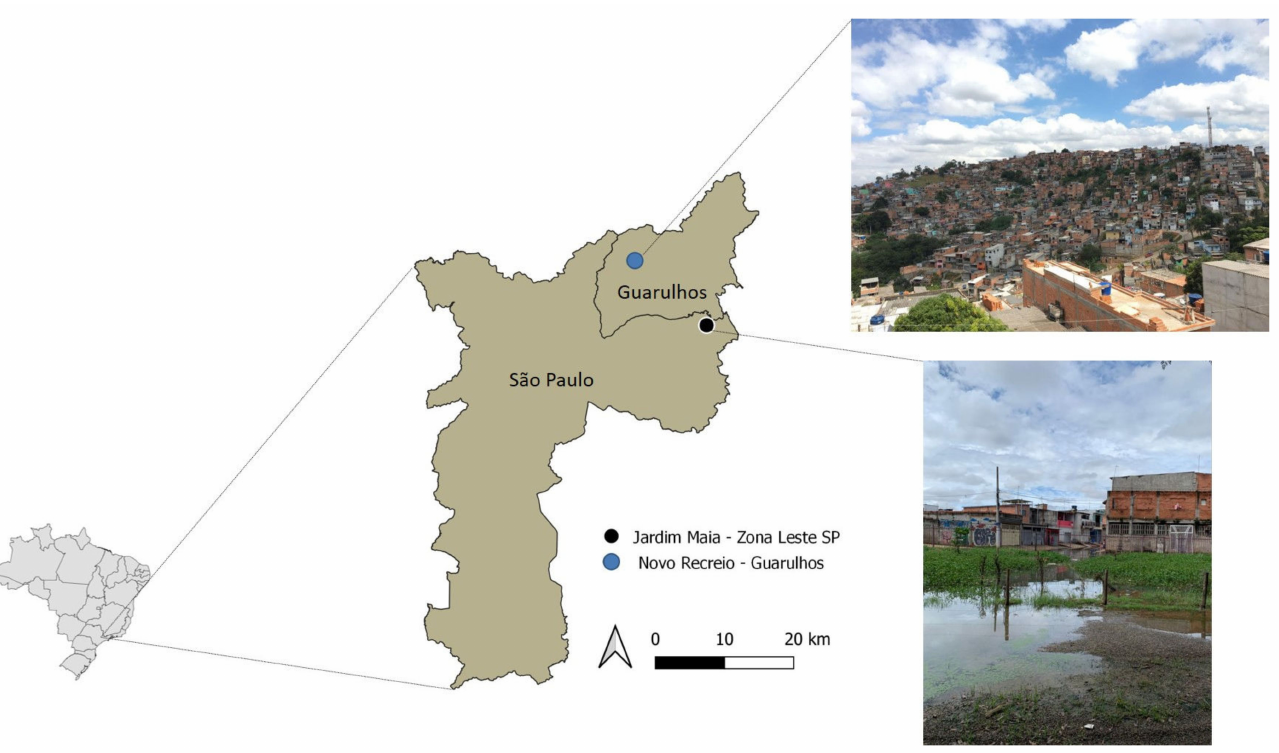
Figure 2. Map of the study areas. Source: Authors’